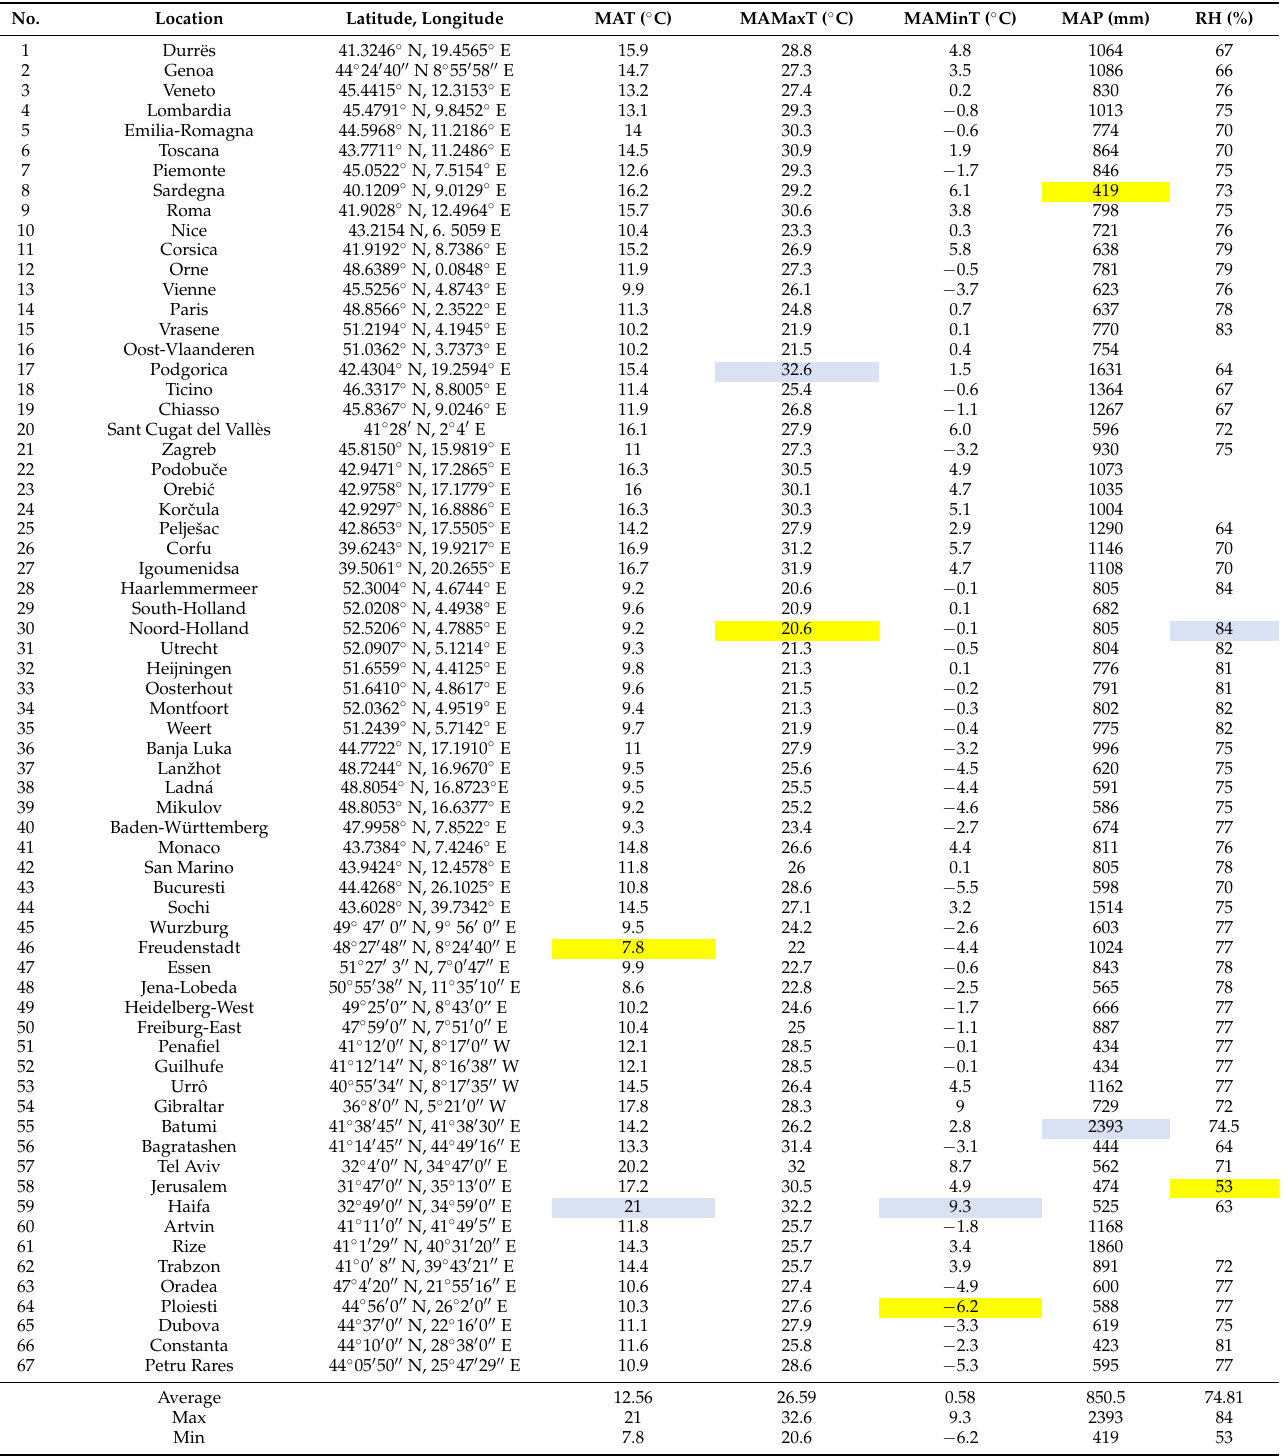
Table 1. Geographical distribution and the climatic parameters for locations where the presence of Ae. albopictus was reported. Mean multiannual temperature (MAT) ( ◦ C), mean multiannual maximum temperature (MAMaxT), mean multiannual minimum temperature (MAMimT) ( ◦ C), mean multiannual precipitation (MAP) (mm), mean multiannual humidity RH (%). The minimum and maximum values of the investigated parameters are highlighted in blue and yellow